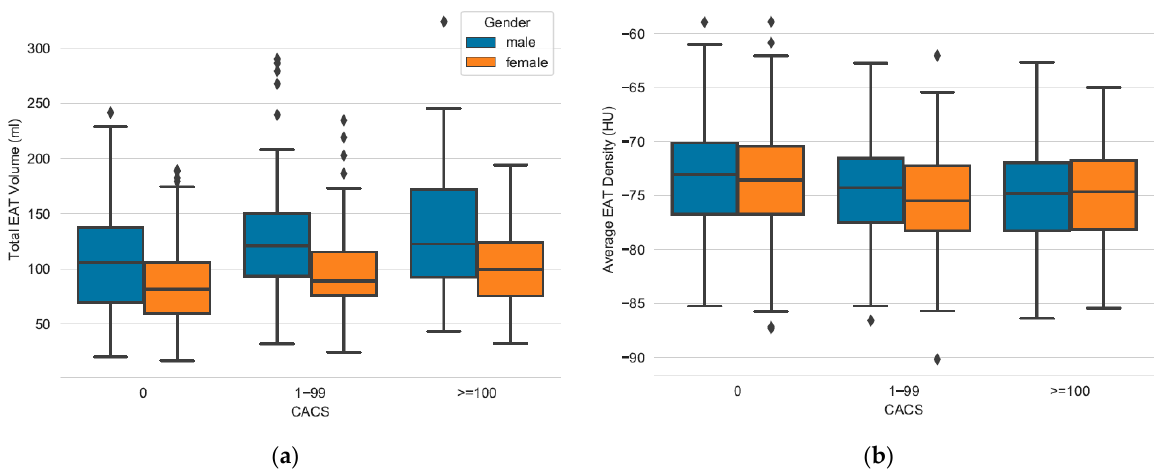
Figure 2. Comparing EATvol and EATatt between CACS categories and gender groups. ( a ) EAT volume increases significantly between CACS 0 vs. CACS 1–99 in women and men. No significance between CACS 1–99 vs. CACS ≥ 100 for both sexes. ( b ) EAT attenuation increases significantly between CACS 0 vs. CACS 1–99 in women, but not in men. No significance between CACS 1–99 vs. CACS ≥ 100 for both sexes (see Table 3). Table 3. Inter-group comparison of CACS groups itemized into gender groups (both/male/female) regarding their signif- icance. The results of Dunn’s Test are stated as not applicable (N/A) when the Kruskal-Wallis test does not reach the significance level.